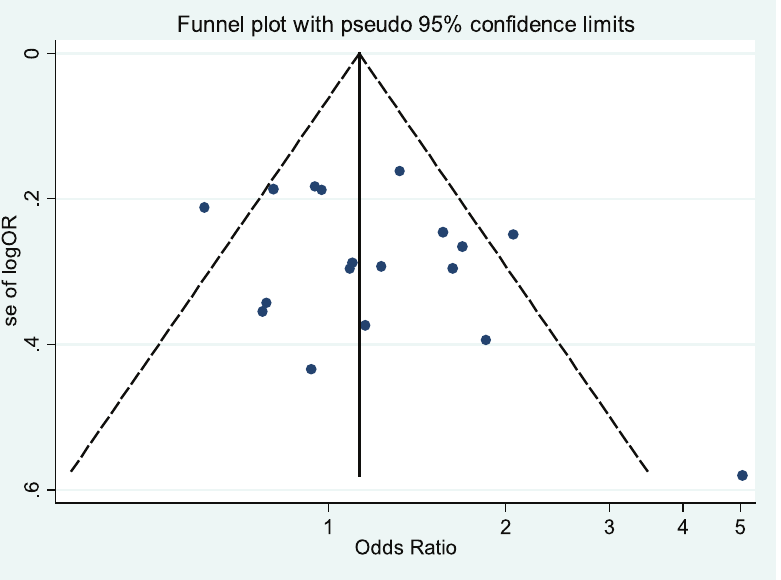
Figure 7. Funnel plot of publication bias for IL-8 -251 A/T SNP (AA vs TA). Note: Funnel plot with pseudo 95% confidence limits was used.